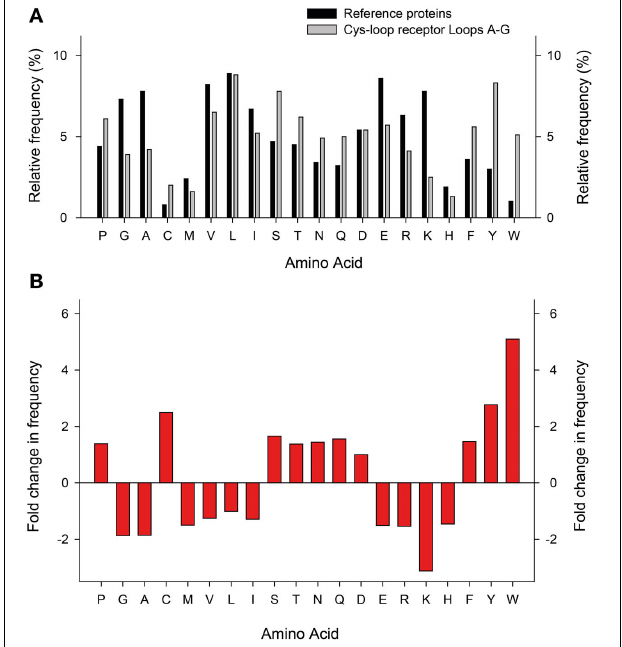
FIGURE 4 | Relative abundance of amino acids in Cys-loop receptor agonist-binding loops. (A) Relative frequency ( y-axis ) at which each amino acid ( x-axis ) appears in a set of 520 proteins (dark columns; Brooks et al., 2002) and in the 25 Cys-loop receptor agonist-binding loops as shown in Figure 3 (light columns). (B) Fold increase (positive numbers) or decrease in frequency at which amino acids appear in Cys-loop receptor agonist-binding loops compared to the general protein